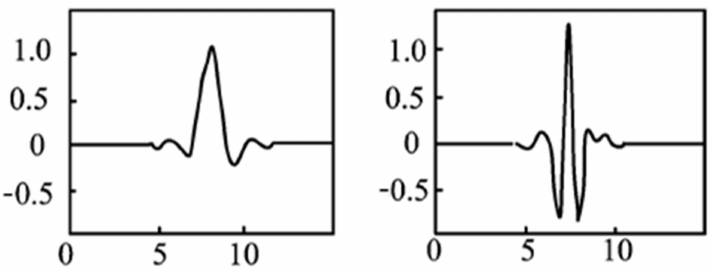
Figure 3. Symlets wavelet scaling function and wavelet function (generated by